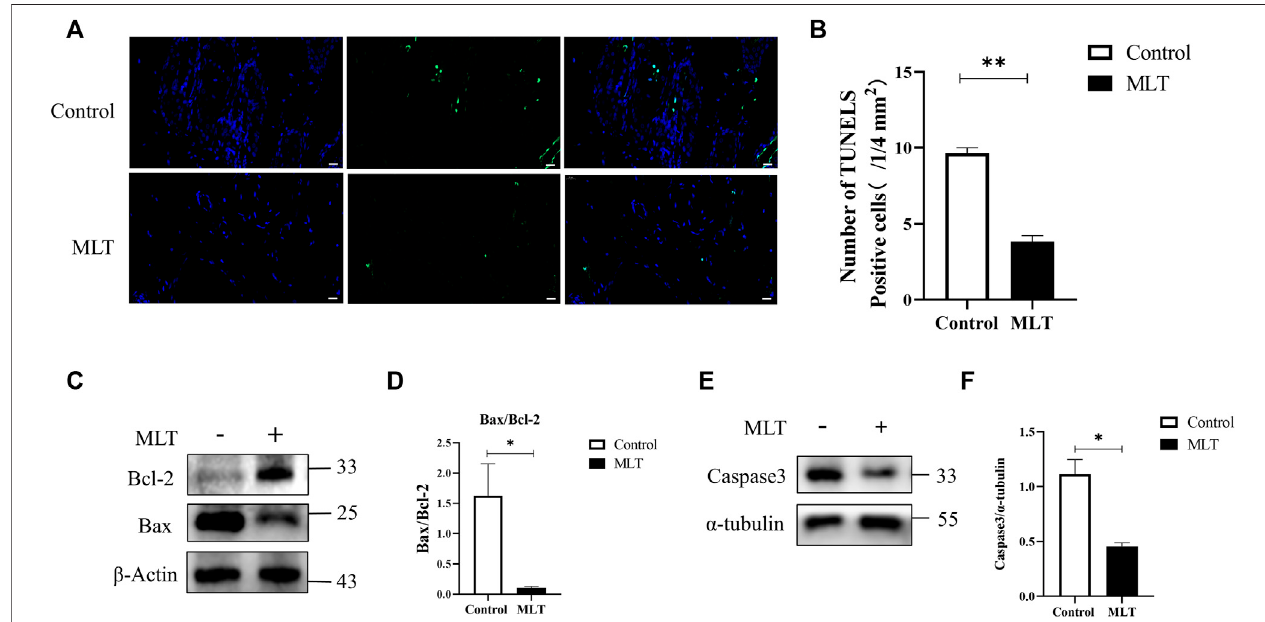
FIGURE3| MLTsuppressedapoptosisinthenecroticareaofthe fl ap. (A) Detection ofapoptosis byTUNELassayScalebar:20 μ m. (B) Relative quantitativedata of apoptotic cells and TUNEL cells. Signi fi cant differences between the groups are indicated by ** p < 0.001. (C) Protein levels of Bcl-2, Bax, and β -actin detected by Westernblotting. (D) Quantitative analysisoftheproteinexpression levelsofBax/Bcl-2. Signi fi cantdifferences betweencolumnsareexpressed as* p < 0.05. (E) Protein levels of caspase3 and α -tubulin detected by Western blotting. (D) Quantitative analysis of the protein expression levels of caspase3 and α -tubulin. Signi fi cant differences between columns are expressed as * p < 0.05. Abbreviations: MLT, melatonin.